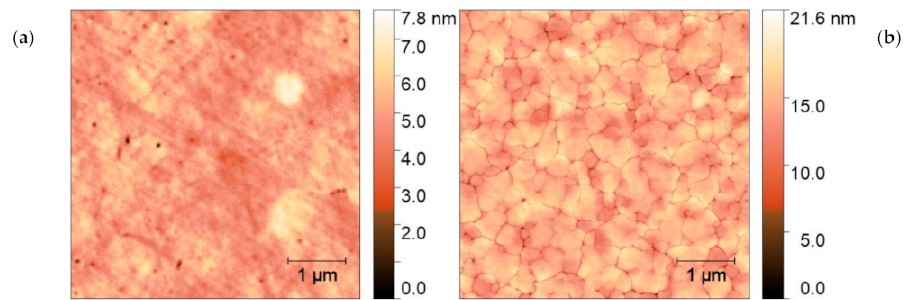
Figure 8. AFM surface images of TiO:Eu thin film ( a ) as deposited and ( b ) after PLA processing, 400